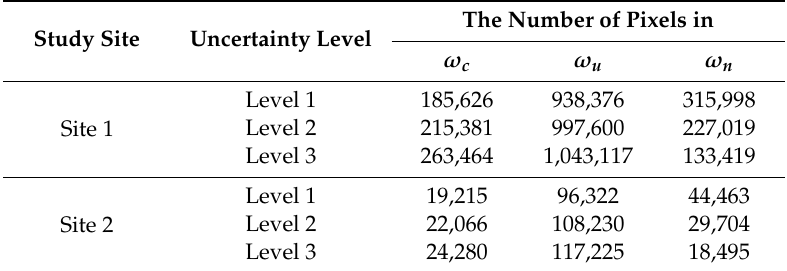
Figure 9. CD objects overlapped with the boundaries of segments at different uncertainty levels: Level 3 at ( a ) Site 1 and ( d ) Site 2; Level 2 at ( b ) Site 1 and ( e ) Site 2; and Level 1 at ( c ) Site 1 and ( f ) Site 2. ω c , ω u , and n are the change, no-change, and no-value classes of the initial CD object, respectively. Table 2. The number of pixels with different classes and uncertainty levels.